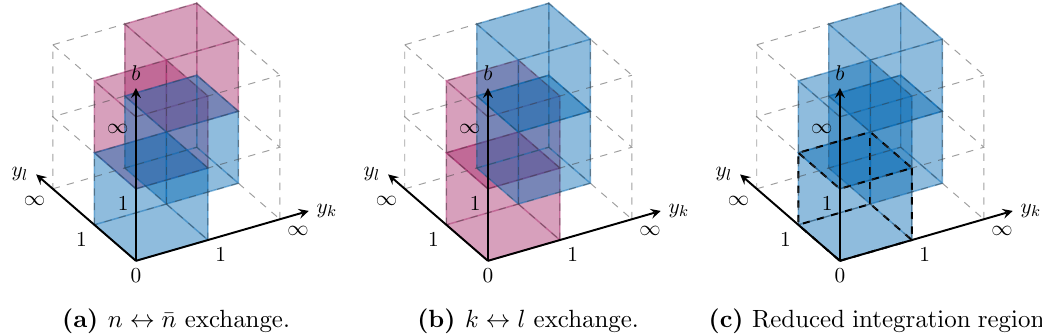
Figure 1. Reduction of the integration domain in the variables y k , y l and b for the uncorrelated- emission contribution. Cubes of the same colour correspond to integration regions which yield the same result according to the stated symmetries. The second integration region B, complementing the highlighted region A in (c), can be any of the white adjacent cubes. In practice it is most easily recovered from A by inverting either y k or y l